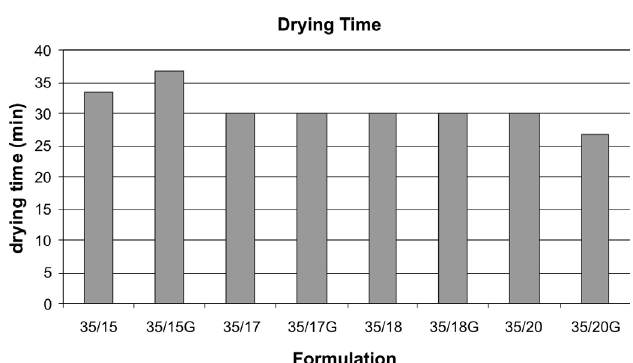
FIGURE 1 - Mean of in vitro drying time (min-triplicate) of the formulations obtained from the modifications in the peel off facial mask F35 , in the condition of Oven (36.5 ± 1.0 °C).